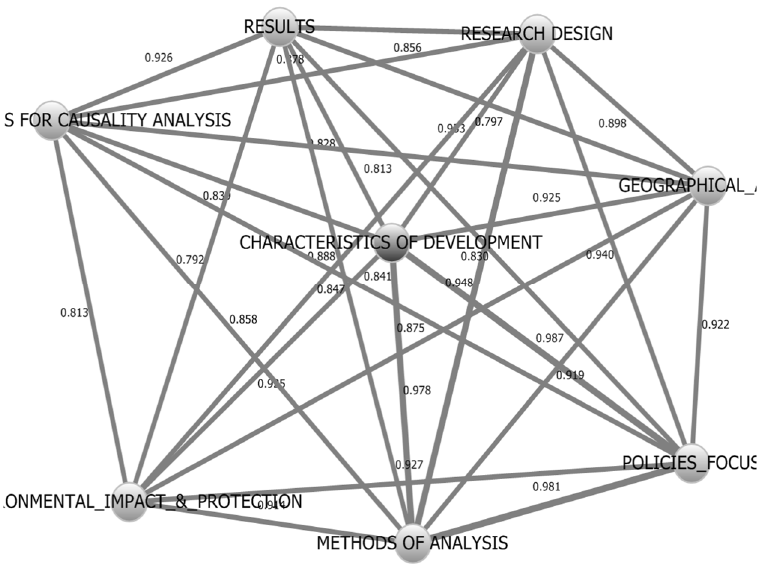
Figure 4. The link between the eight categories for the entire period. There are some minor changes in the analysis over the three periods; the three categories stated maintain their strongest connection.